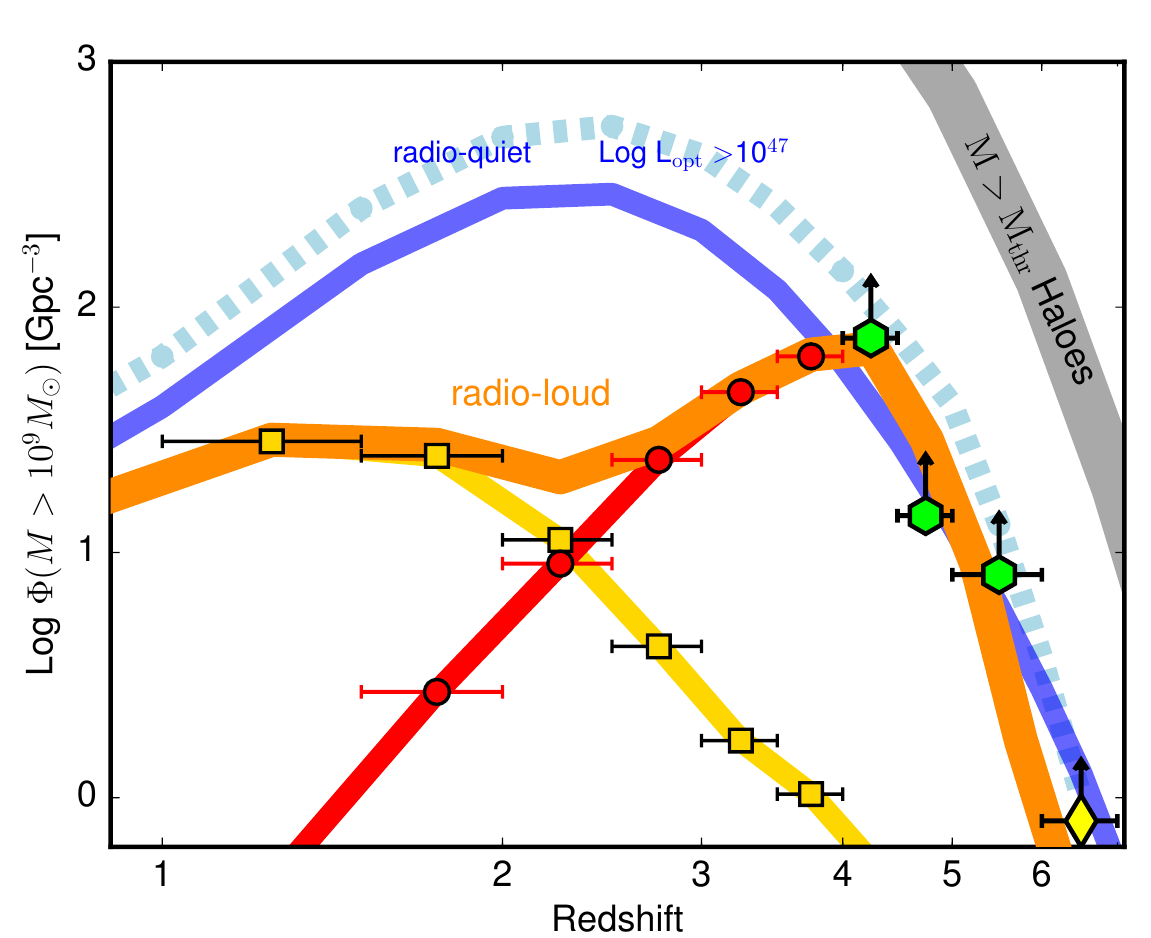
Figure 1. Comoving number density of active supermassive black holes with M BH 10 9 M hosted in jetted (orange line) ≥ (cid:12) and non-jetted active galactic nuclei (AGNs) (blue line). The non-jetted density is derived from the luminosity function of radio-quiet quasars in the Sloan Digital Sky Survey (SDSS) [17], by assuming that all quasars with L opt > 10 47 erg/cm 2 /s host black holes with masses we are interested in (following the assumptions considered by Ghisellini et al. [20] while extracting the same quantities from Hopkins et al. [22]). As a comparison, the light blue dashed line is the comoving number density derived from Hopkins et al. [22]. The jetted-related curve is instead formed by the sum of luminosity functions from Fermi /Large Area Telescope (LAT) (yellow line and points) and Swift /Burst Alert Telescope (BAT) (red line and points), up to z 4. Green hexagonal lower limits are derived from the systematic classification of blazar candidates from SDSS and (cid:39) Faint Images of the Radio Sky at Twenty-Centimeters (FIRST), based on X-ray observations and corrected by the sky area covered by the survey. The yellow diamond lower limit refers to PSO J0309+27, the farthest blazar currently